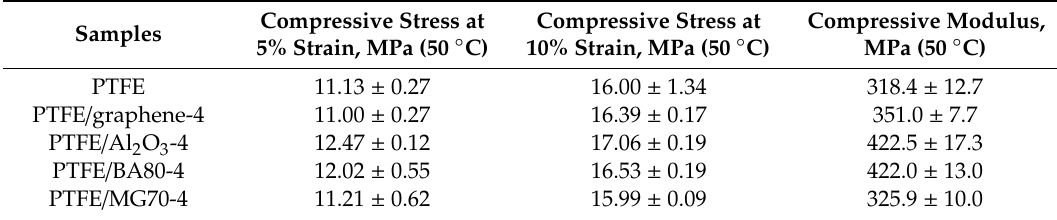
Figure 9. Shear and tensile elongation of unfilled and filled PTFE samples. The grey and green transparent lines display the shear and tensile elongation of neat PTFE, respectively.